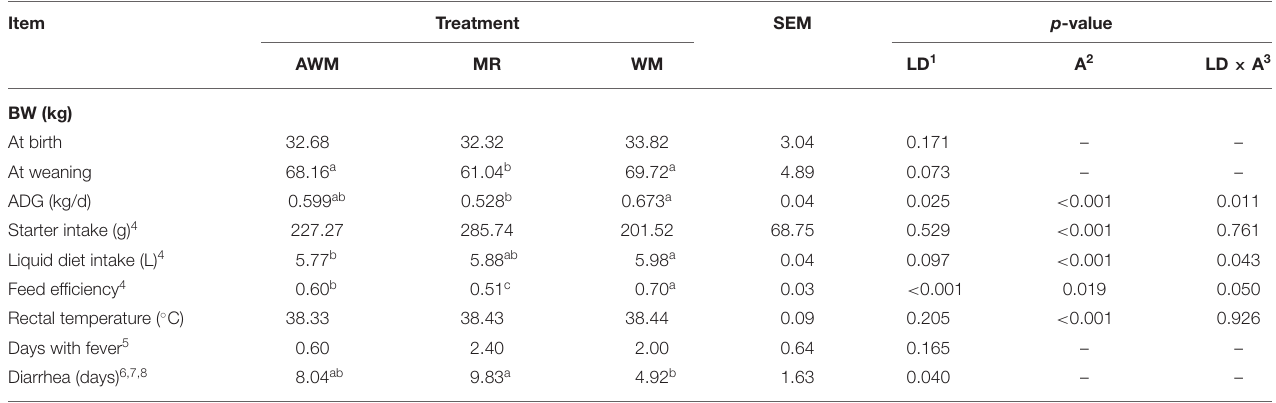
TABLE 2 | Performance, intake and health from birth to weaning of calves fed with different liquid diets. Item